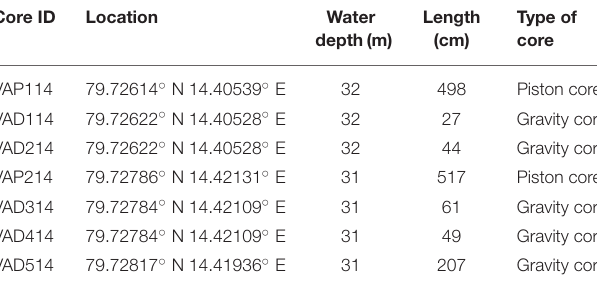
km 2 , are found in Cirrusdalen and Grennadalen, respectively. TABLE 1 | Overview of sediment cores retrieved from